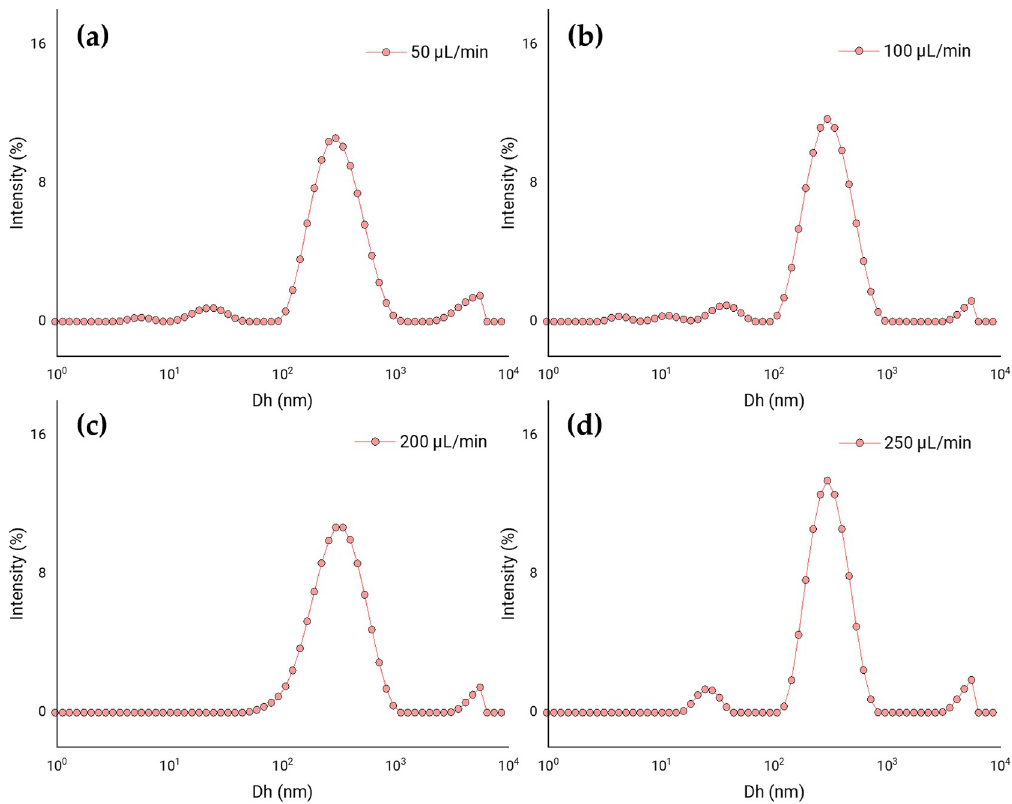
Fig 3. Effect of TPP dripping. Distribution of apparent hydrodynamic diameters (Dh) according to the percentage of dispersion intensity, showing the effect of the TPP flow rate on the ionic gelation of CS MPs with PEITC. Results corresponding to the process with homogenisation with ultrasound pre- and post-ionic gelation, and with a drop rate of TPP of 50 μ L/min ( a ); 100 μ L/min ( b ); 200 μ L/min ( c ); 250 μ L/min ( d ).